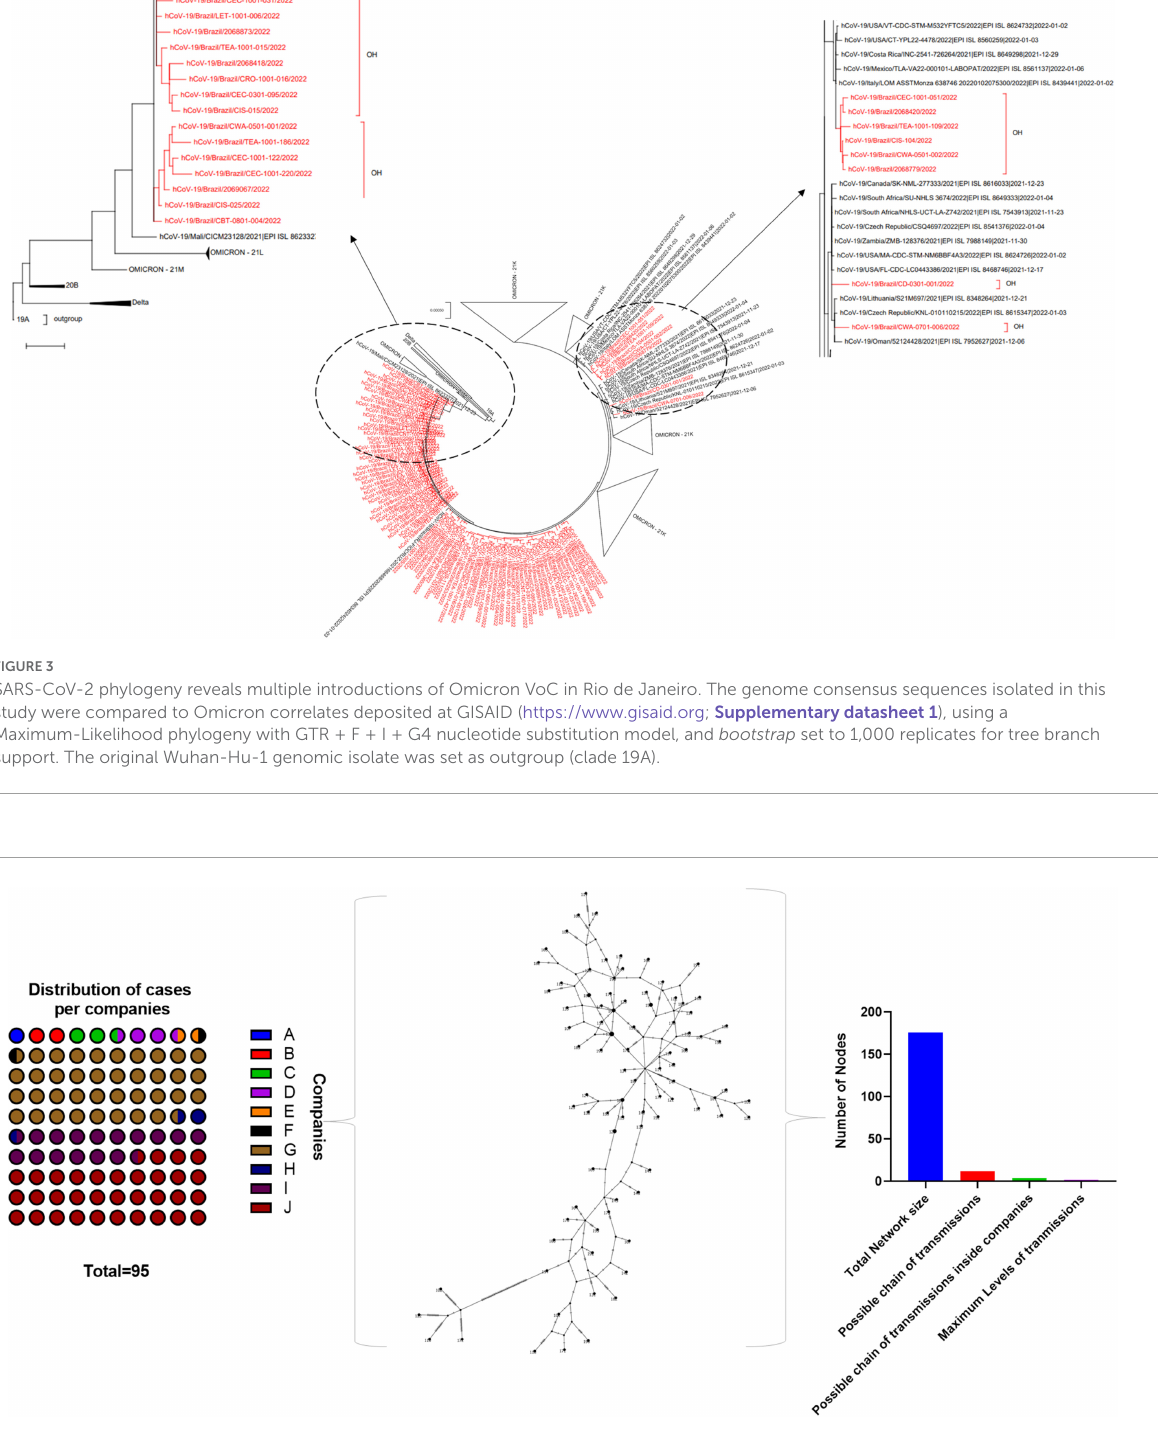
FIGURE4 Implemented SARS-CoV-2 programs impairs transmission at the workplace. Isolated SARS-CoV-2 genome sequences were distributed across their respective companies of origin, and subsequently analyzed into a haplotype network. Interacting nodes were quantified according to different criteria, to reveal possible transmission chains, between and within companies. The haplotype network was inferred with the TCS method (i.e., statistical